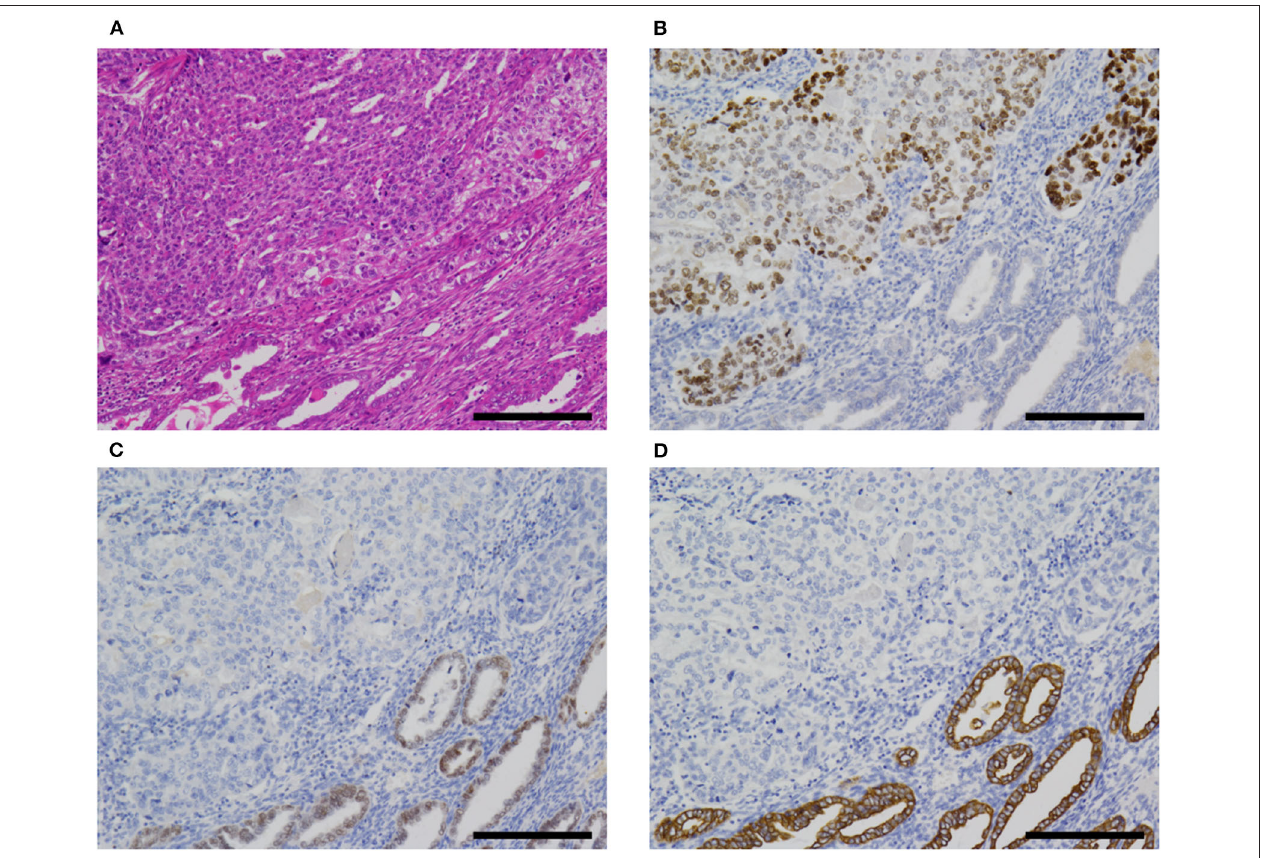
FIGURE 5 | AFP + EC associated with Müllerian component (case 2). (A) In cases 1 (not shown) and 2, AFP + EC was associated with Müllerian carcinosarcoma (sarcomatous component not shown). (B–D) The former (upper left) was SALL4 + (B) , PAX8- (C) , and CK7- (D) , while the latter (lower right) was SALL4-, PAX8 + , and CK7 + . Hematoxylin-eosin (A) ; original magnification × 100; scale bars = 200 µ m. AFP + EC, α -fetoprotein-producing endometrial